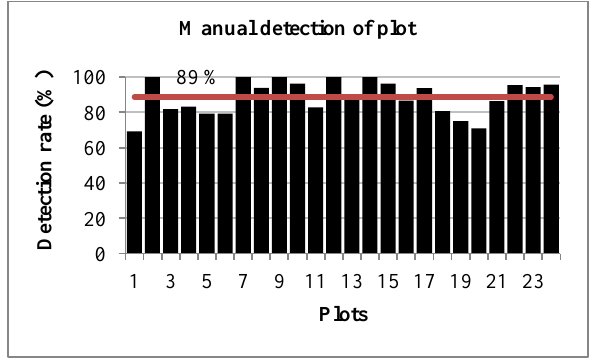
Figure 9. Manual detection rate of trees per